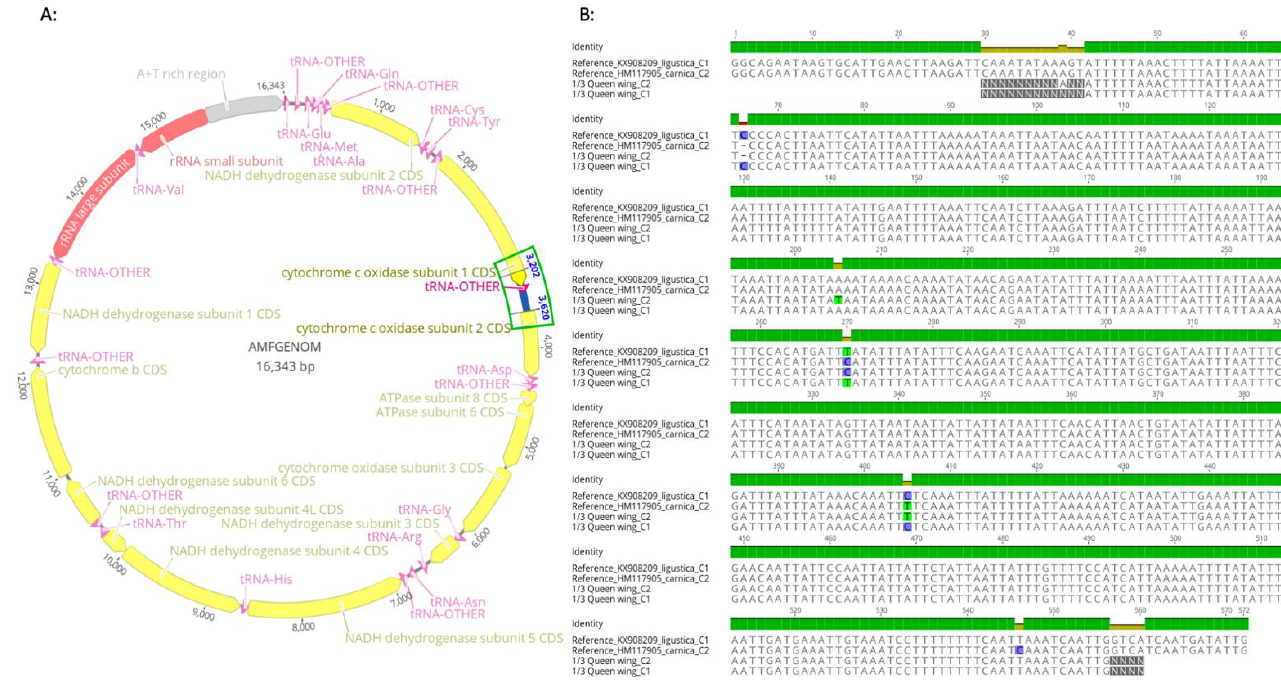
Figure 3. Structural organization of the honey bee mtDNA and COI-COII location. ( A ) Complete mitochondrial DNA genome of the honey bee Apis mellifera [29] annotated and showing the location of the intergenic region. ( B ) Successful sequencing of the mtDNA intergenic region using DNA extracted from one-third of a queen wing. Sequences were aligned with NCBI reference haplotypes C1 and C2 (KX908209, HM117905) using GENEIOUS Prime Software. Analyzed queens exhibited both C1 and C2 haplotypes, which correspond to ligustica and carnica subspecies, respectively.